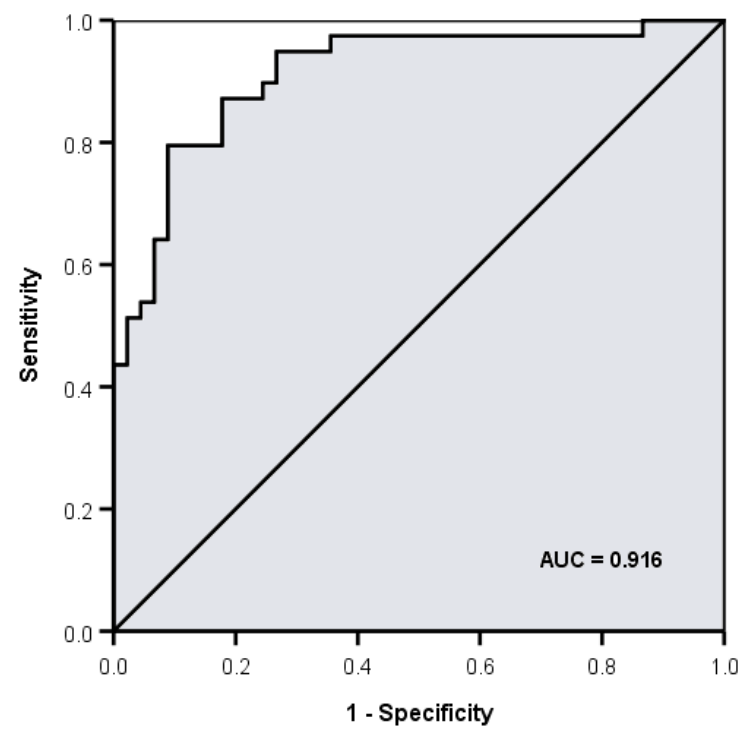
Figure 6. Area under the receiver operating characteristic curve (AUROC) for discrimination between extended spectrum β -lactamase (ESBL) positive and negative strains using 6 volatiles (retention times (min) 16.68, 18.5, 19.47, 20.40, 24.36 and 25.02) = 0.912.